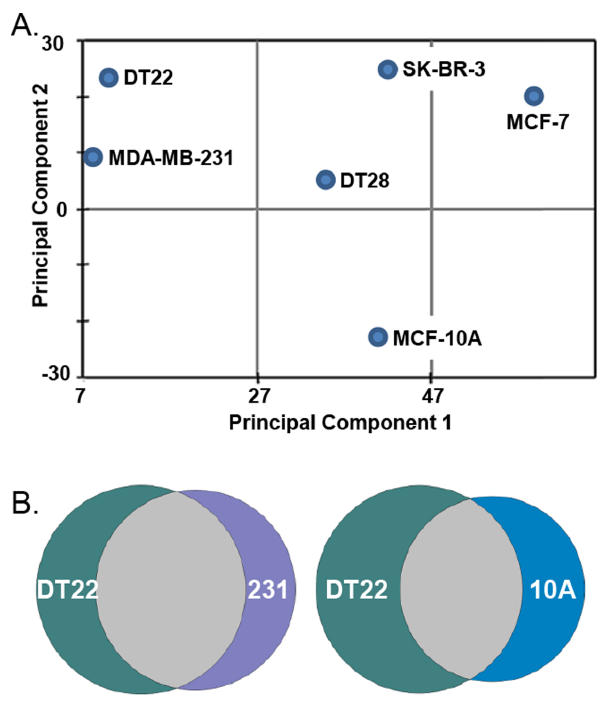
Figure 3. Comparison of PM proteomes shows similarities and differences among the cell lines. A. Relationships between the data sets can be visualized by clustering those that share similar expression profiles. B. Venn diagrams highlight the degree of similarity between DT22 and MDA-MB-231 (231) cells compared to DT22 and MCF-10A (10A)